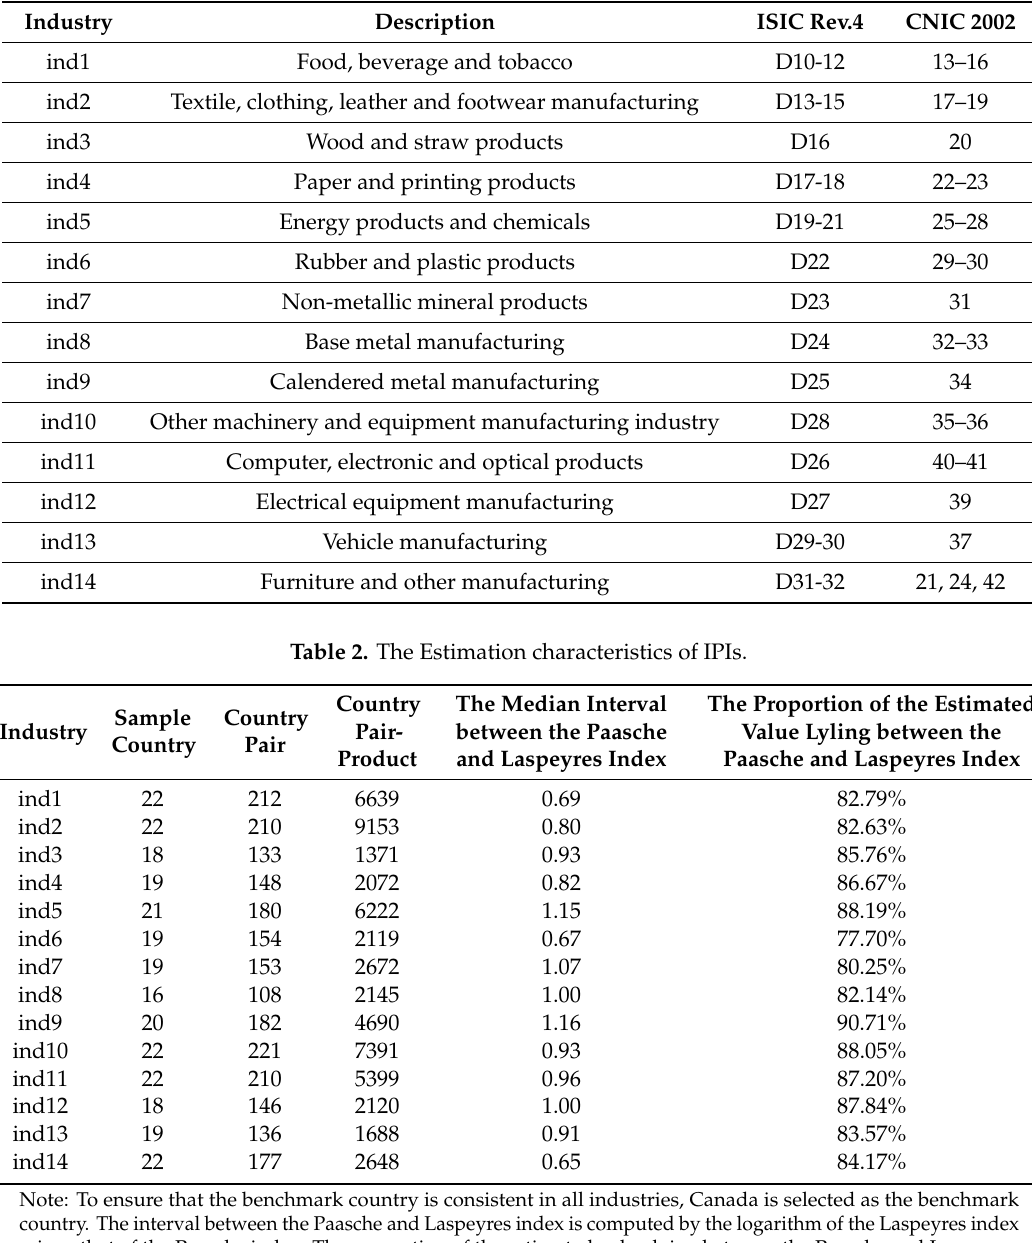
Table 1. Correspondence table between ISIC Rev.4 and China’s National Industrial Classification